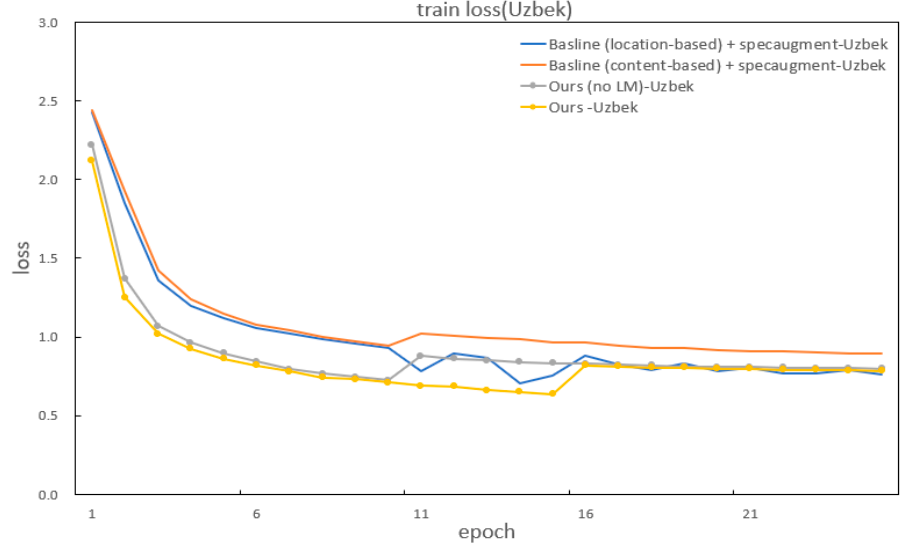
Figure 8. The train loss of the baseline and our methods for Uzbek.